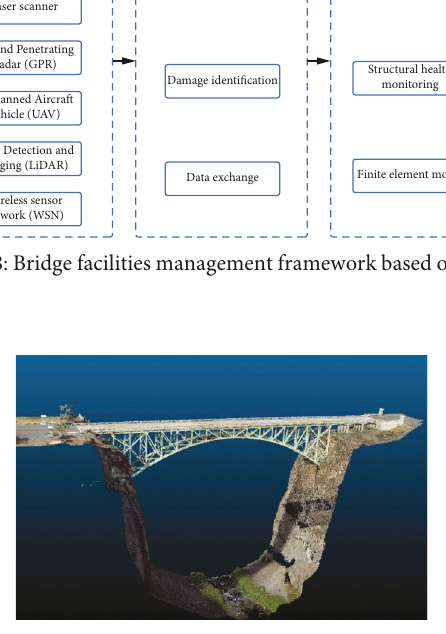
Figure 9: 3D point cloud of the crooked river bridge